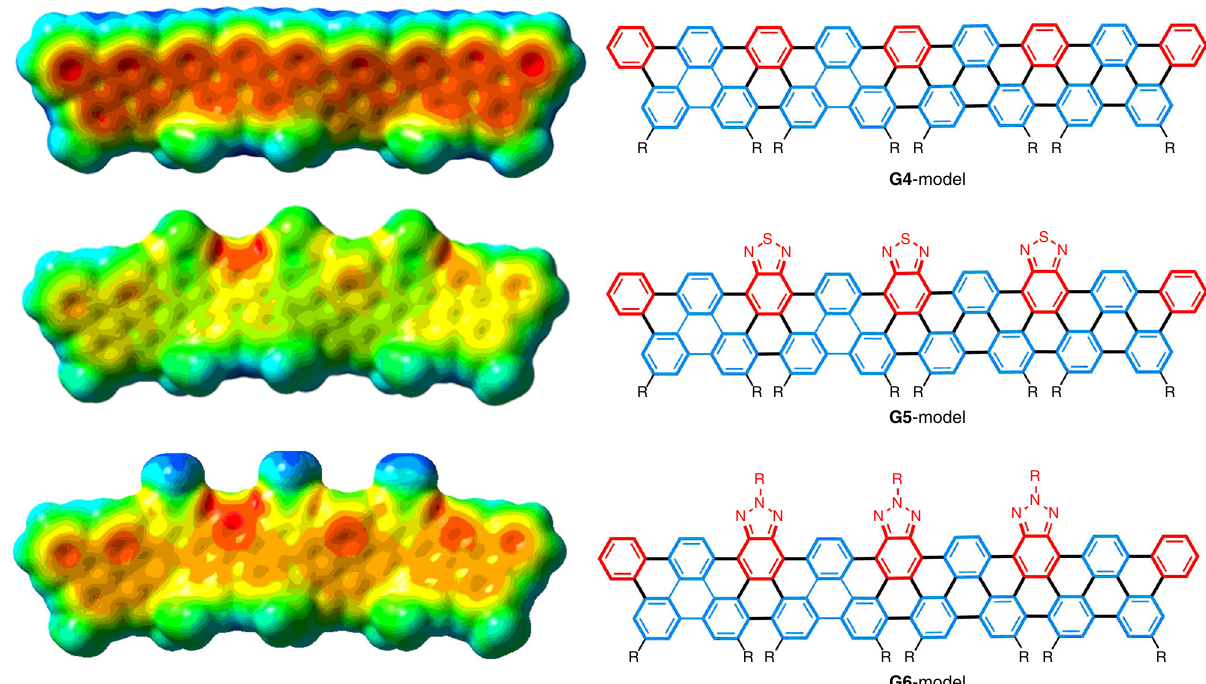
Fig. 5 DFT calculation. Electron density of G4 – G6 - models (trimer models). Areas of higher electron density are colored red, and areas of lower electron density are colored